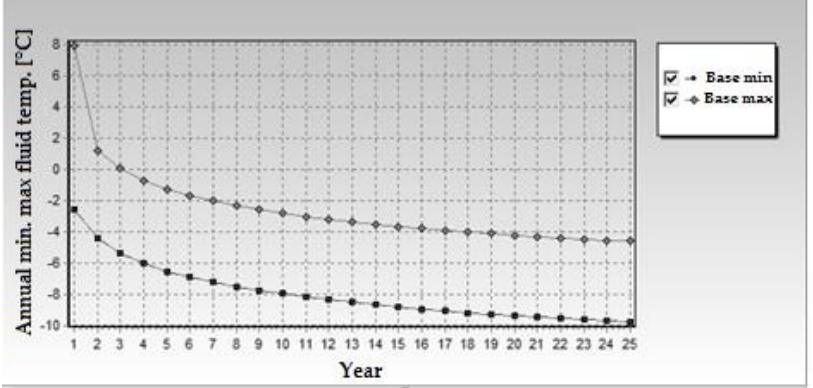
Figure 7. Temperature progression over 25 years under Scenario 1 (calculated by